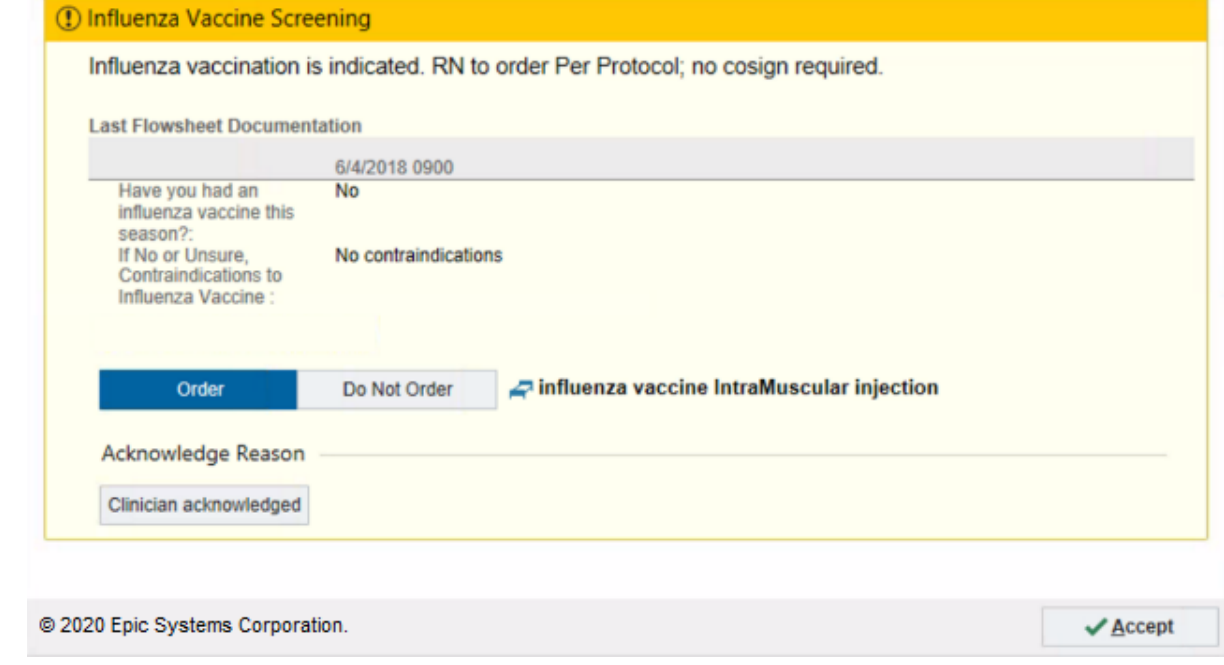
Figure 4. Version 3 of the flu alert, in which an acknowledgement reason button was added and the “dismiss” button was removed. Copyright 2020, Epic Systems